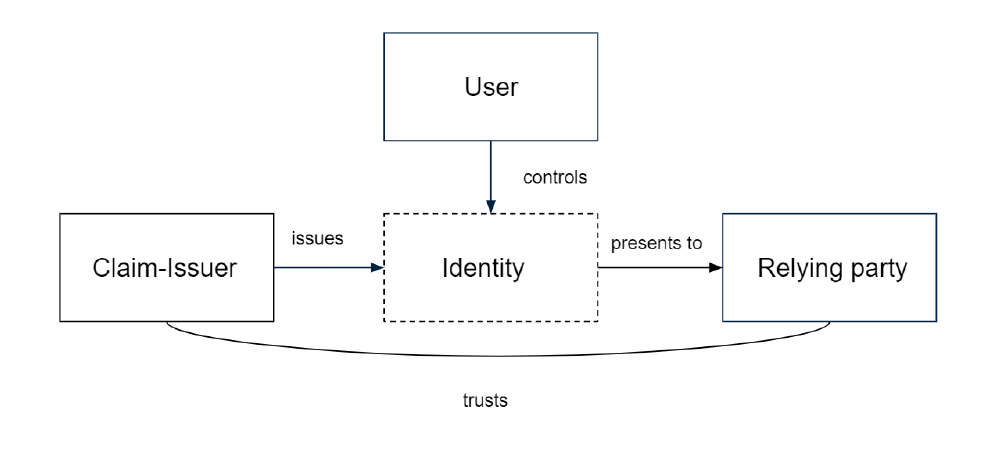
Fig. 2. Self-Sovereign Identity Actors.